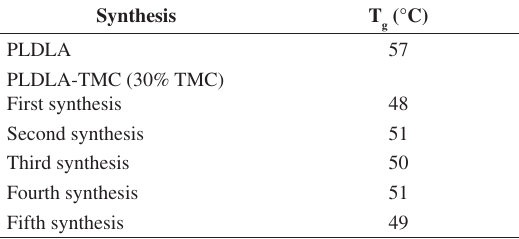
Table 5. Glass transition temperatures (Tg) for the second heating of PLDLA and PLDLA-TMC as determined by DSC.